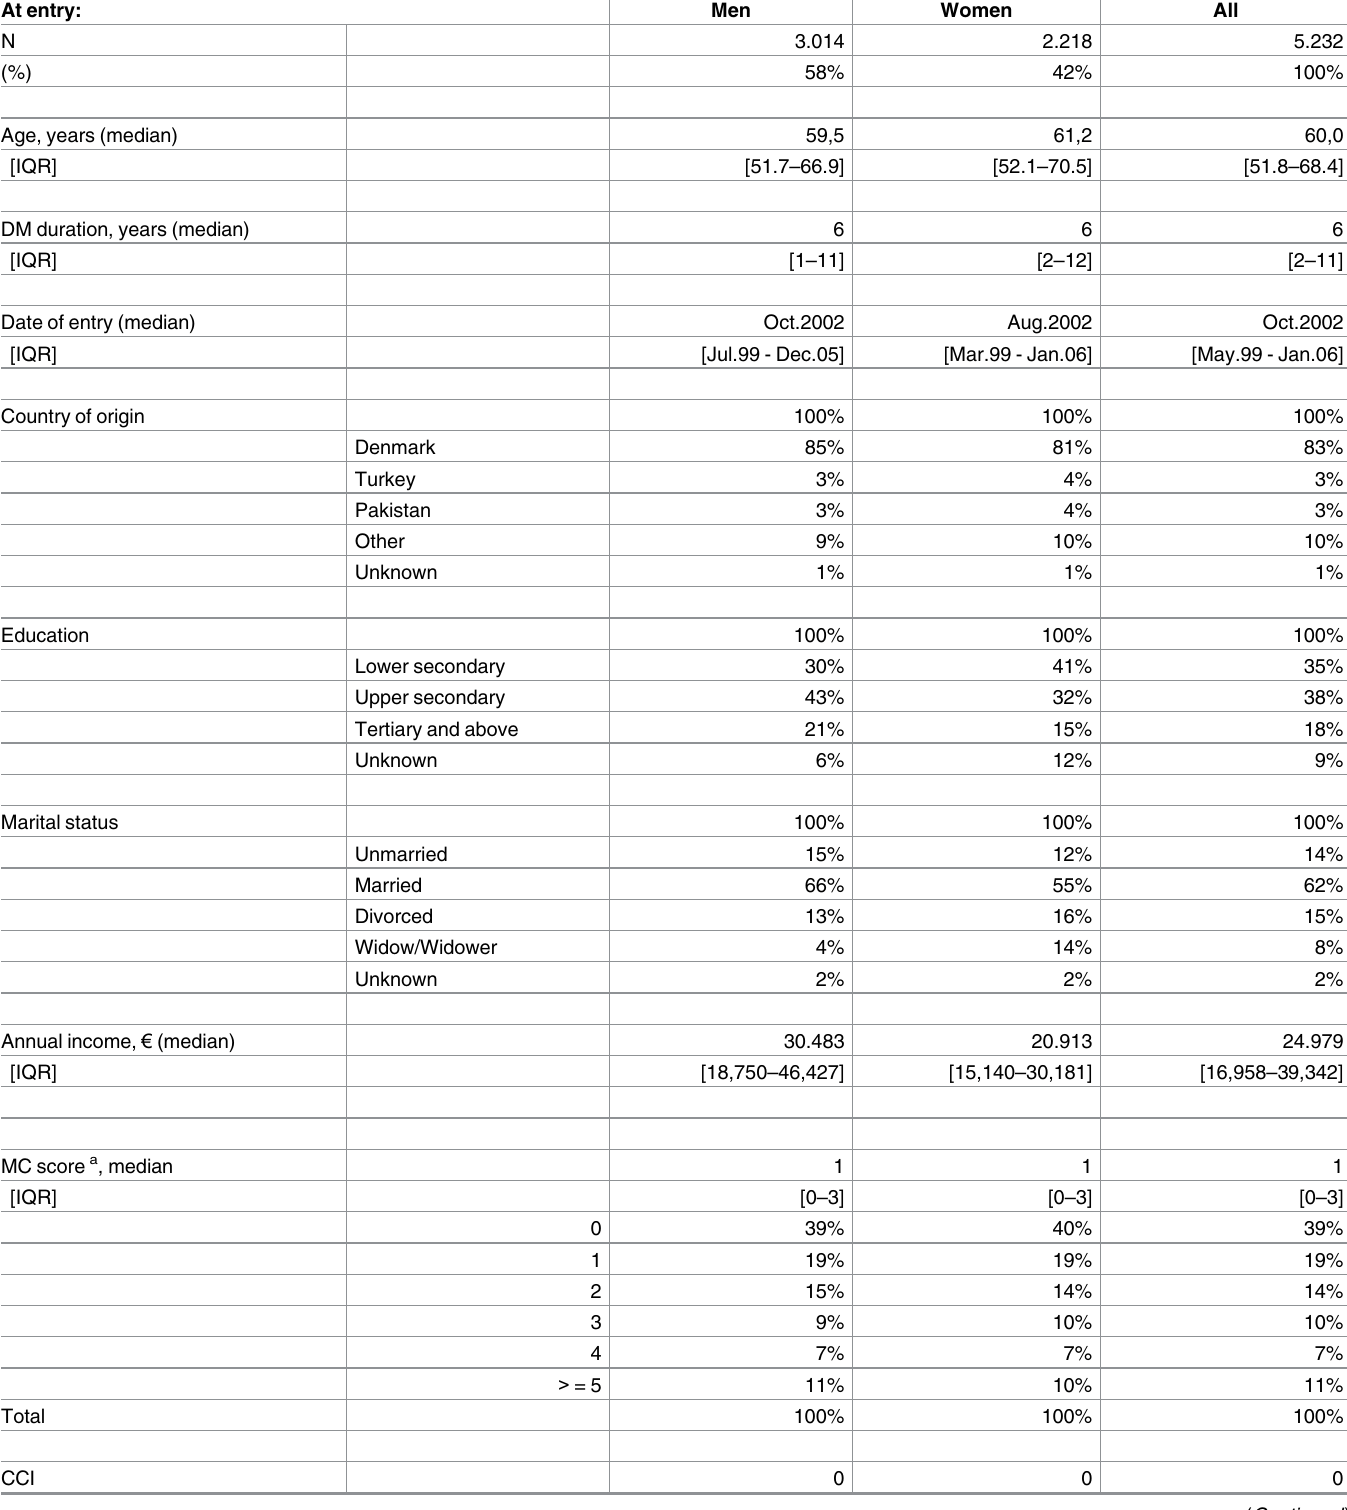
Table 2. Baseline